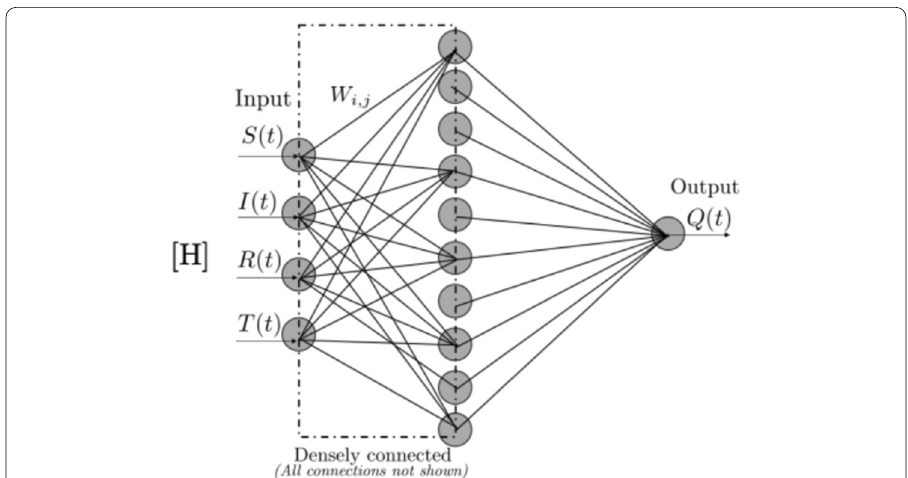
Fig. 19 The Neural Network takes an input vector of the Susceptible, Infected, Recovered, and Quarantined Population (estimated from the previous time step) to model the quarantine strength (Image taken from Dandekar and Barabastathis [135])